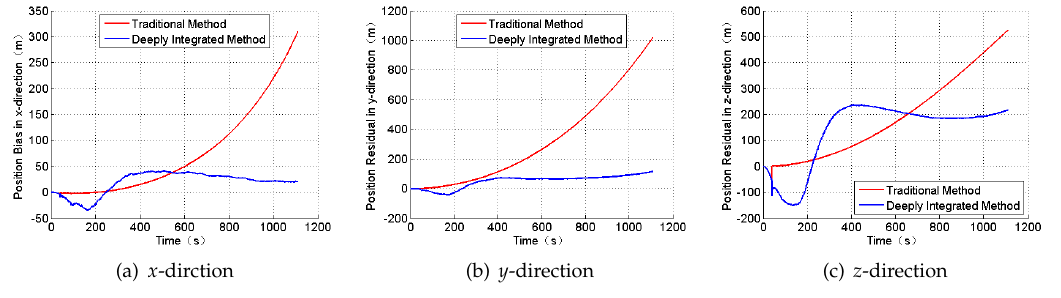
Figure 6. The position residual.